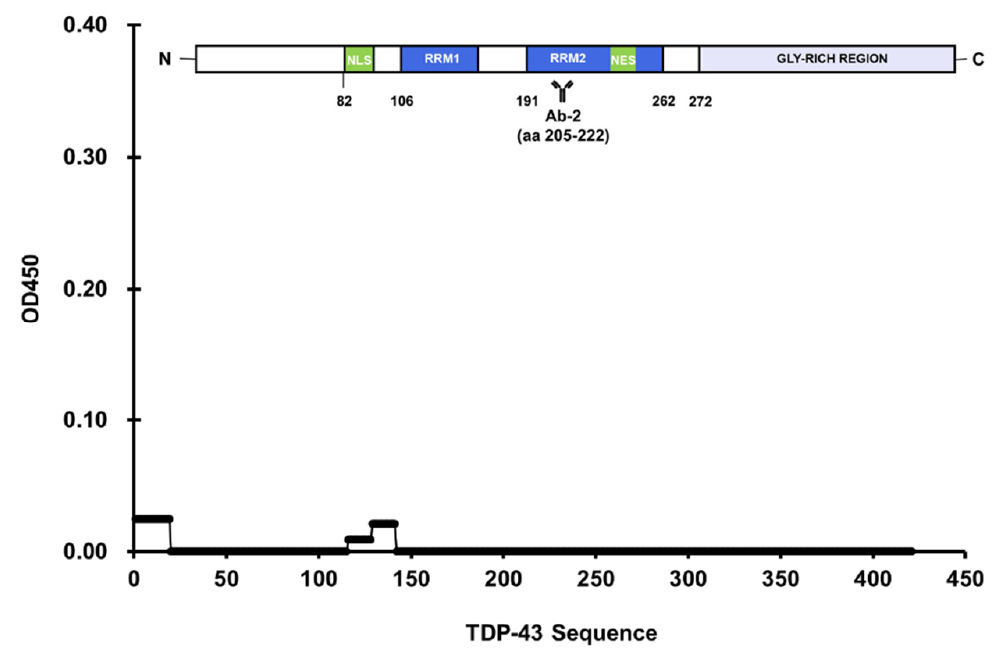
Figure 5. No significant reaction in all TDP-43 peptides was observed during treatment with Ab-2 (2E2D3).